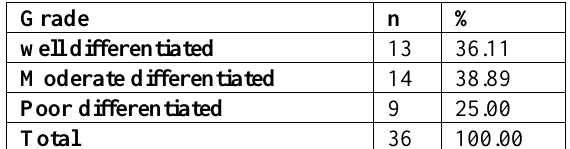
Table 5: Association between Ang-2 expression and Gender of the study group Gender